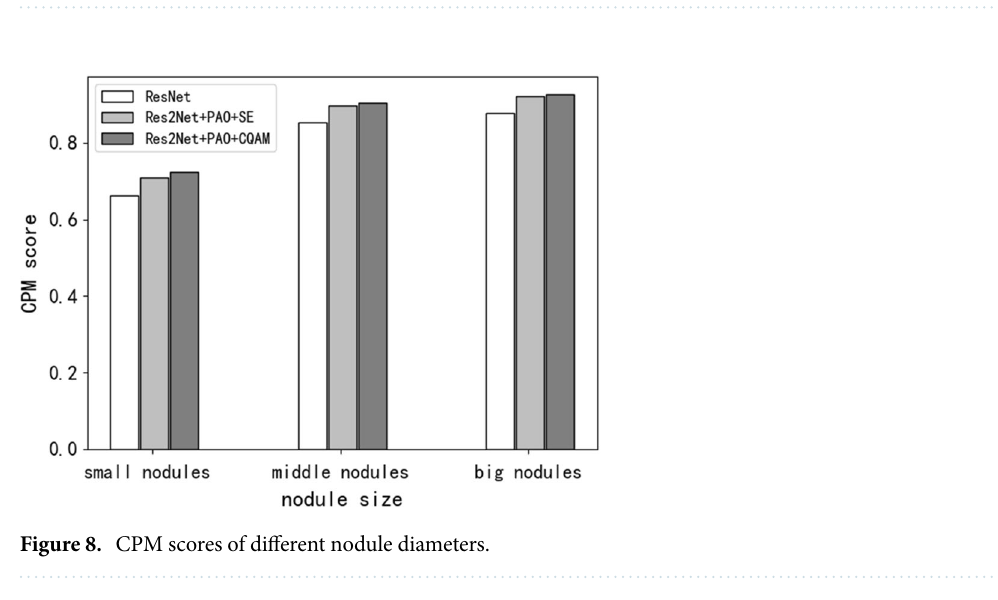
Table 2. The examples of pulmonary nodule detection results on the LUNA16 dataset.